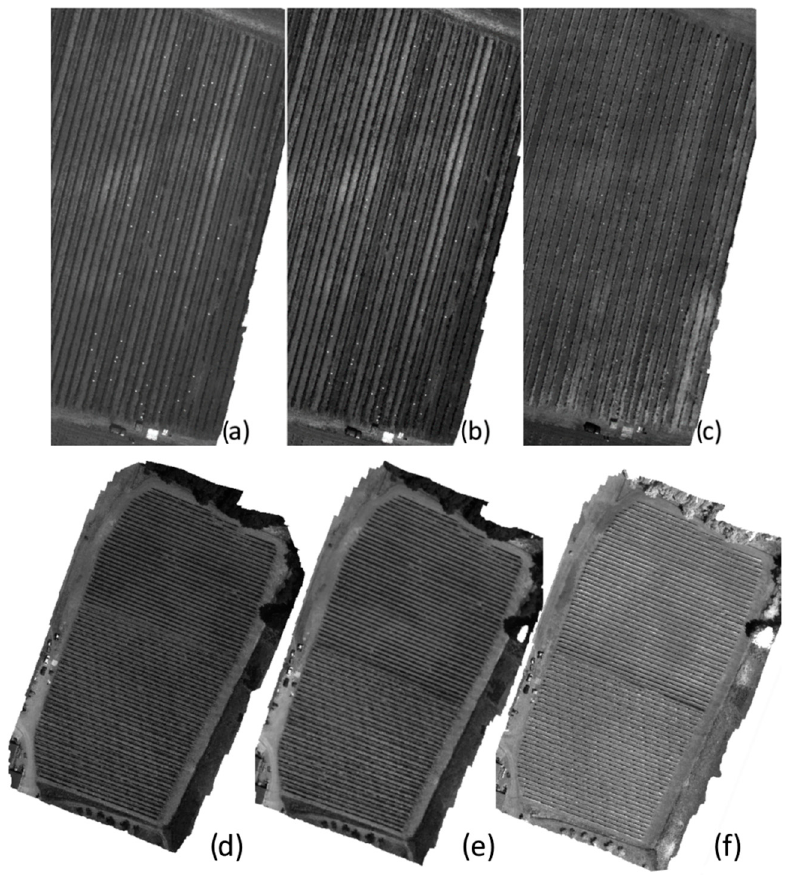
Figure 21. Overview of the single band mosaics ( a – d ) band 520 nm; ( b – e ) band 600 nm and ( c – f ) band 810 nm, for both Piacenza and Chianti study areas, respectively. Map details related to scale and geographic coordinates are reported in Figure 14.